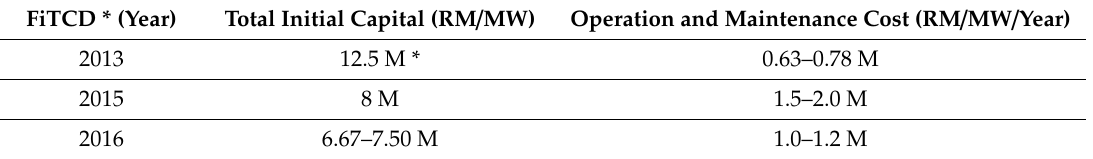
Table 6. The total initial capital and operation and maintenance cost per MW of LFG installation (Source: SEDA, Sustainable Energy Development Authority Malaysia). FiTCD *